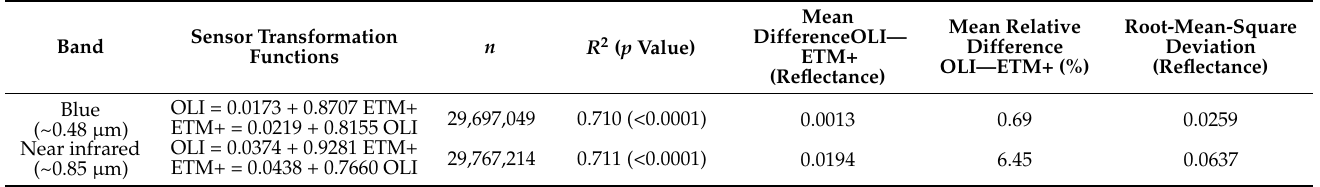
Table 2. Transformation functions between ETM+ and OLI top-of-atmosphere reflectance sensors developed through ordinary-least-squares (OLS) regression (Roy et al.